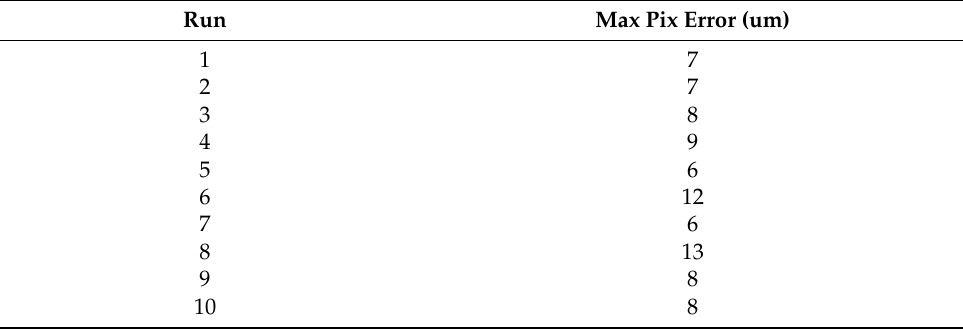
Table 14. PSO real results over 10